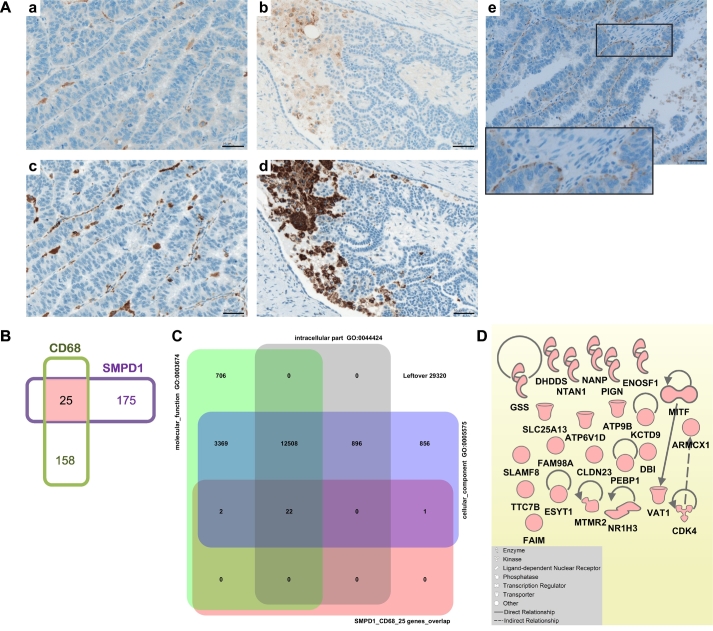
Similarity and overlap in expression patterns between SMPD1 and CD68.A Immunohistochemical staining of tissue sections obtained from patients with serous ovarian cancer; Module III in Fig. 1. Consequent tissue sections were stained for SMPD1 and CD68. Representative images show the overlap in expression for intra-tumoral macrophages (a, SMPD1; c, CD68) and phagocytes organized into phagocytic islands (b, SMPD1; d, CD68). Furthermore, (e) example of SMPD1 expression by the tumor cells is shown; staining was detected at the basolateral side of the epithelial layer; insert: the high-power view. Brown color, SMPD1 or CD68 staining; blue color, nuclear counterstaining with hematoxylin. Scale bar: 50 μm.B Venn diagram shows overlap between genes co-regulated with CD68 and SMPD1 in monocytes/macrophages. For both, CD68 and SMPD1, the top 200 co-regulated Affymetrix probes sets were extracted via GEVESTIGATOR from microarray studies exploring gene expression in monocytes/macrophages (described in detail in Methods). Comparison was done on the basis of the corresponding gene names (n = 183 for CD68; n = 200 for SMPD1). The overlap (color code: rose) between the two lists includes the following 25 genes: CLDN23, ARMCX1, ATP9B, ATP6V1D, MTMR2, KCTD9, TTC7B, SLC25A13, VAT1, NTAN1, MITF, ENOSF1, NR1H3, UNC13B, CDK4, GSS, DHDDS, SLAMF8, NANP, PEBP1, FAM98A, FAIM, ESYT1, DBI, PIGN.C Gene enrichment analysis for Gene Ontology (GO) using GENEVESTIGATOR gene set enrichment tool. The Venn diagram displays the input gene set (SMPD1_CD68_25 genes_overlap; color code: rose) and the top 3 gene sets from the background collection (color code: grey, violet, green). The respective GO terms and annotations are provided. The numbers indicate how many genes are found in overlaps. (D) Gene network reconstruction using the Ingenuity Pathway Analysis Software (IPA) on the basis of the gene set SMPD1_CD68_25 genes_overlap; Module V in Fig. 1. Insert: the IPA-based description of symbols and relationships. (For interpretation of the references to color in this figure legend, the reader is referred to the web version of this article.)